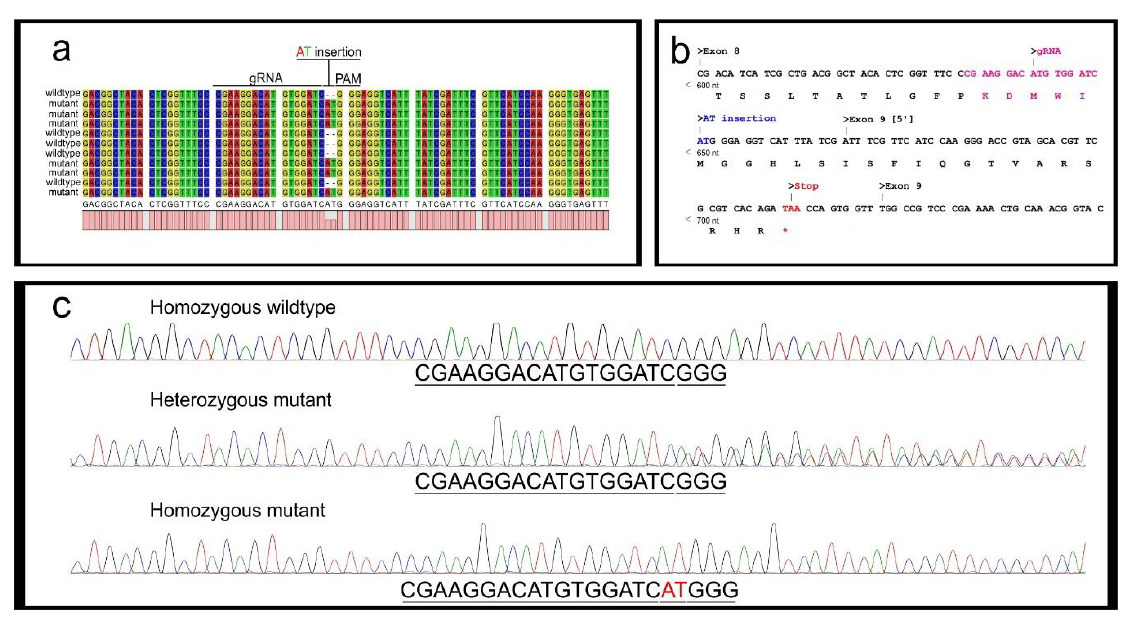
Figure 8. Mutant sequence determination. ( a ) per amplicon Sanger sequencing of five clones derived from two heterozygous egg samples, aligned with a wildtype per sequence. An AT insertion upstream of the PAM site is identified in several sequences; ( b ) per DNA and protein sequences. The AT insertion at the DNA level causes a frameshift mutation resulting in a truncated PER protein composed of 220 amino acids (full length per = 1108 aa). ( c ) Explicative chromatograms of: homozygous wildtype ( top ) and mutant ( bottom ) embryos generate clear single peaks, a heterozygous individual ( middle ) generates double peaks downstream of the PAM site.